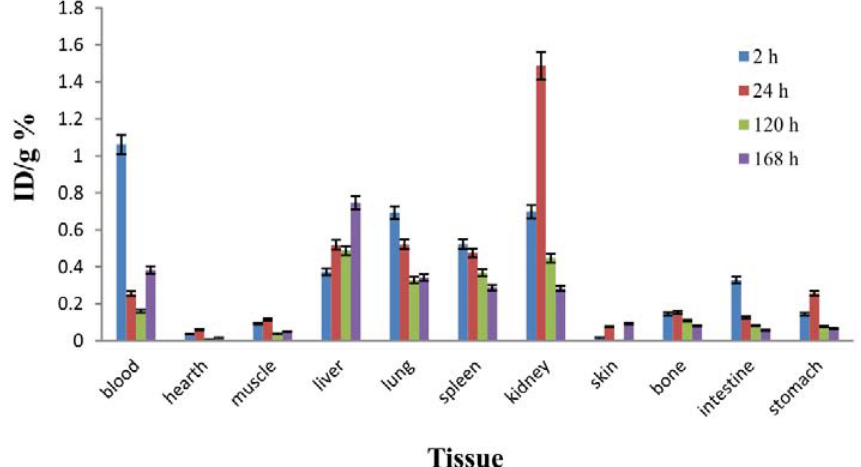
FIGURE 8 - Biodistribution of [ 177 Lu]-TPP (1.85 MBq) in wild type rats 2, 24, 120 and 168 h after iv injection via tail vein (ID/g%: percentage of injected dose per gram of tissue calculated based on the area under curve of 112 keV peak in gamma spectrum)